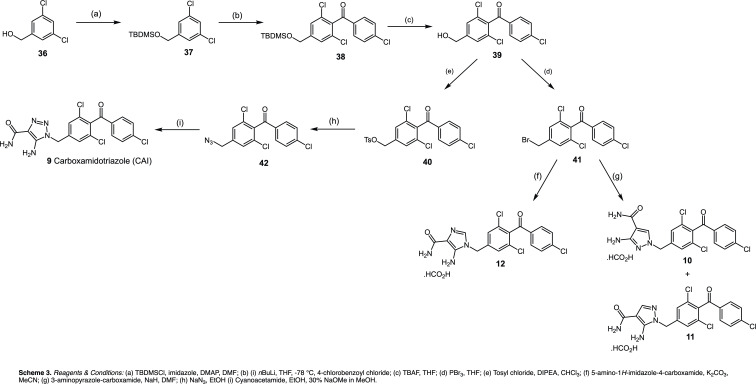
Carboxyamidotriazole analogues.